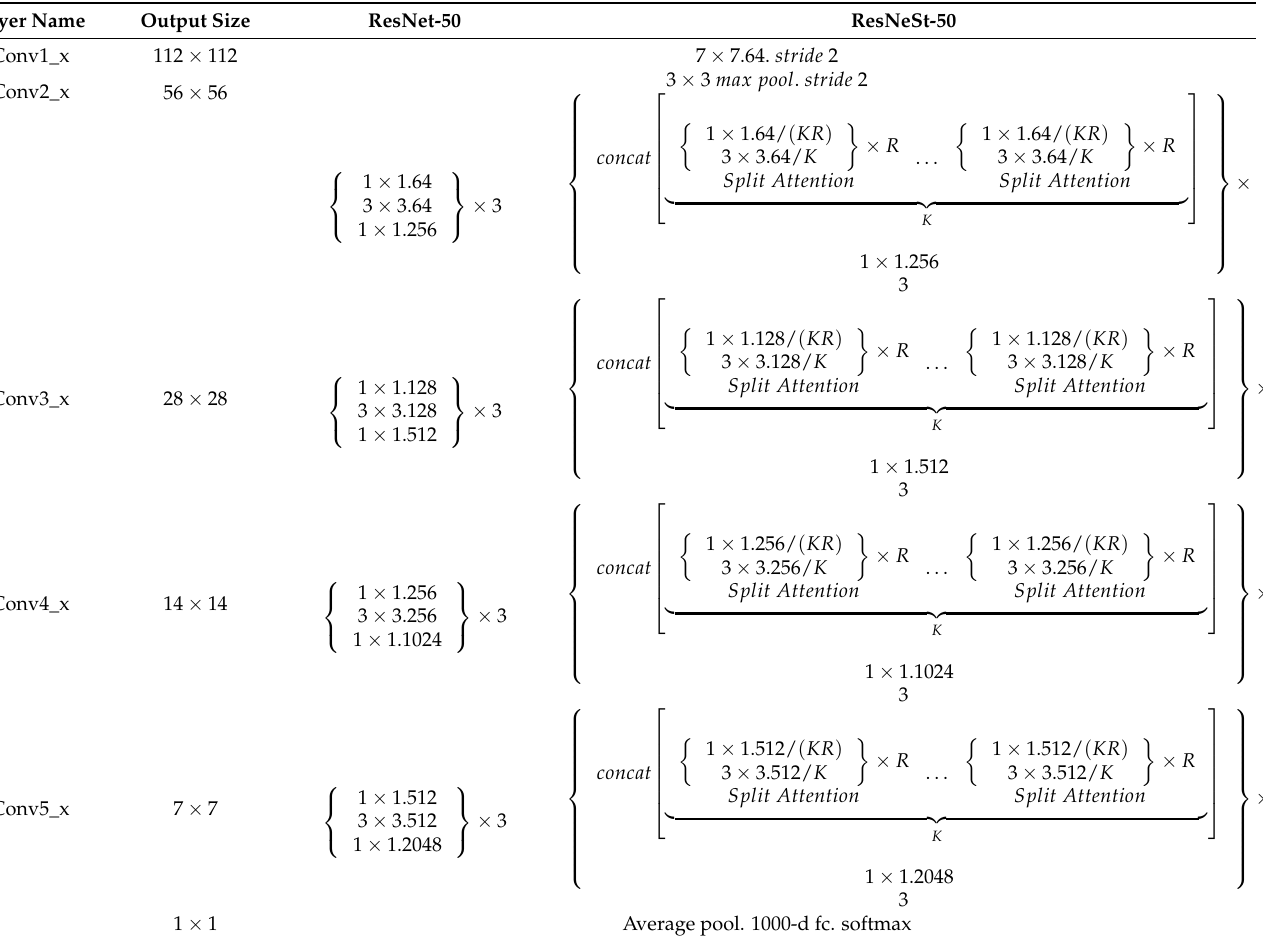
Table 1. The structure composition of the modified backbone and the original DETR